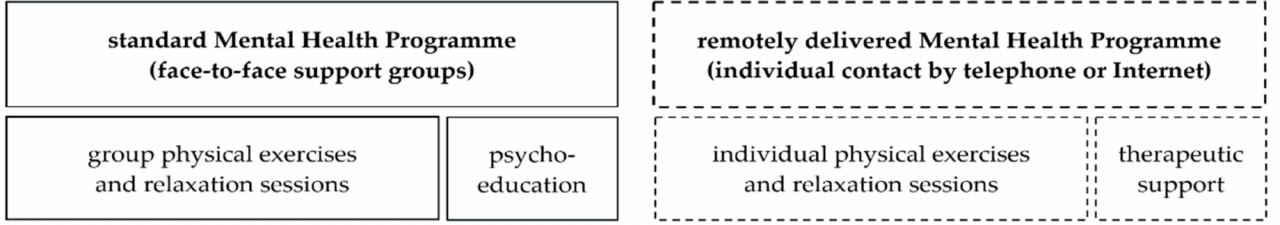
Figure 1. Standard support program and a remotely delivered support